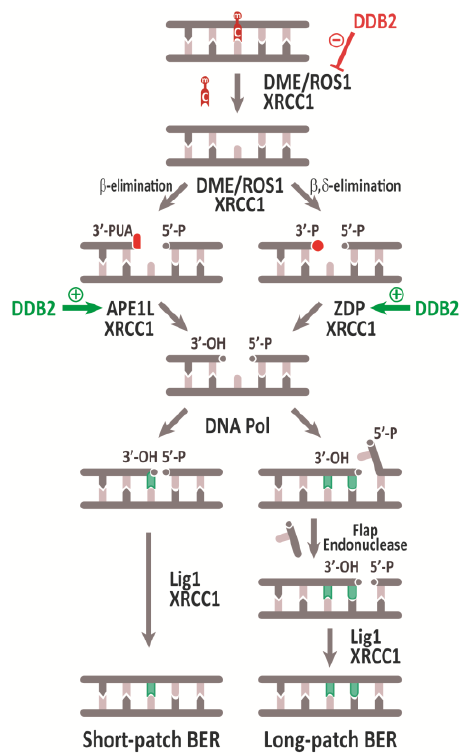
Figure 2. Schematic representation of the active DNA demethylation pathway in Arabidopsis . Different 3’ blocked ends are indicated in red. Stimulatory or inhibitory effect of DDB2 over different proteins of active DNA demethylation pathway are indicated with green or red arrows, respectively. See text for details.